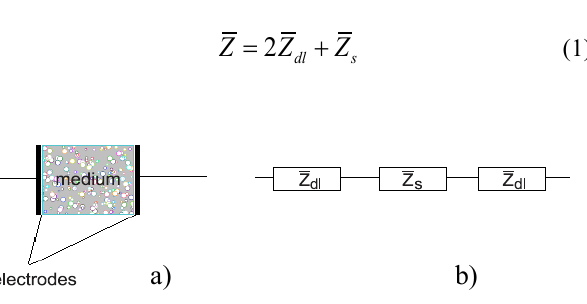
Fig. 3: a) medium (suspension) in the measurement cell and b) electrical equivalent of the measured